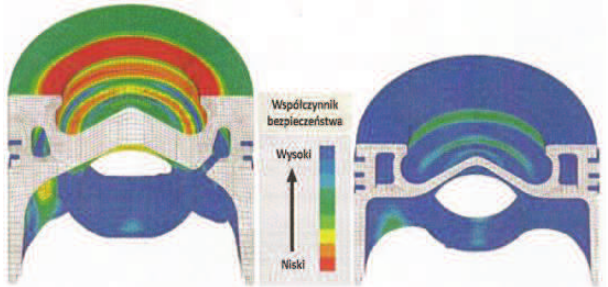
Fig. 5. Distributions of safety factor in aluminum and steel pistons